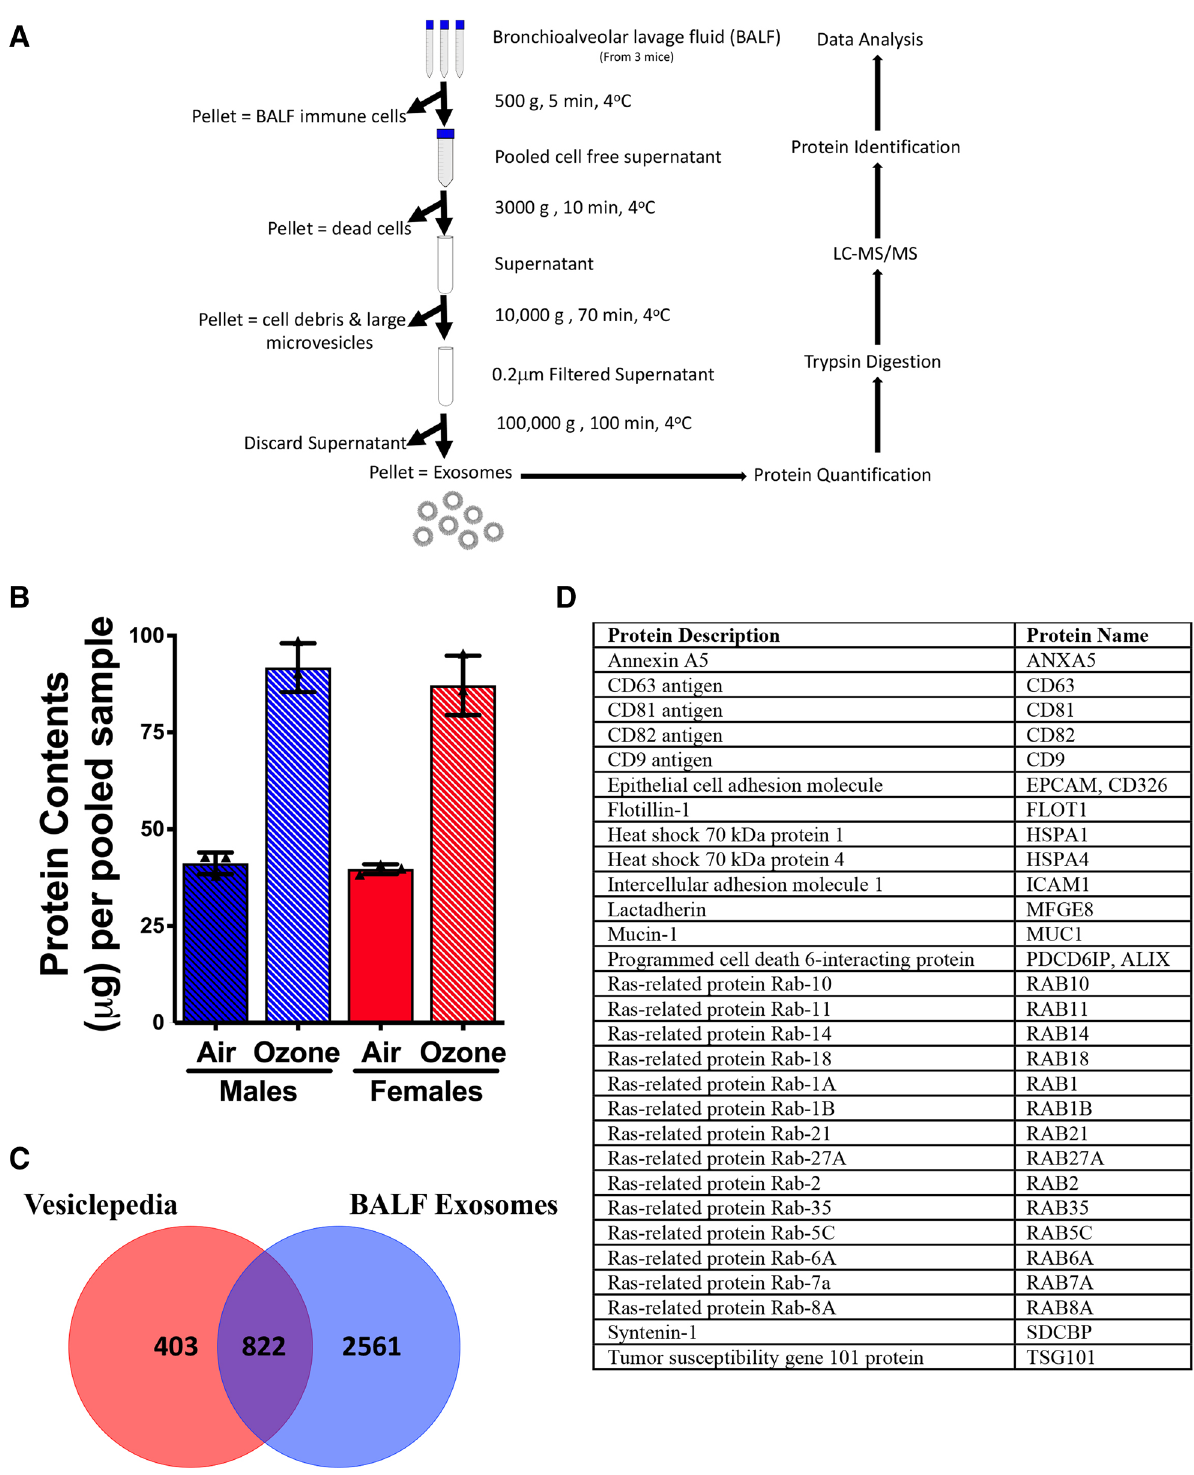
Figure 2. Exosome harvest and analyses for exosome-specific protein signatures. ( A ) Flow diagram (created with www. biore nder. com) delineating designated steps involved in BALF processing for proteomics data analyses. ( B ) Total protein yield (µg) in the exosomes harvested from the air- and ozone-exposed males and females. Significant main effect was detected (Kruskal Wallis Statistic = 8.744; df = 3; p = 0.006). Error bars represent Standard Deviation (SD). Analysis was done using Kruskal Wallis test followed by Dunn’s post hoc comparisons (n = 3 per group). ( C ) Venn diagram to show that 822 out of 1225 exosome-specific markers obtained from Vesiclepedia database were present in exosomes harvested in this study. ( D ) Table showing 29 exosome markers that were represented in the top 20% of the most abundant